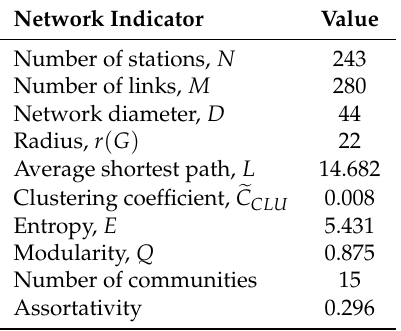
Table 1. Summary statistics of network indicators.